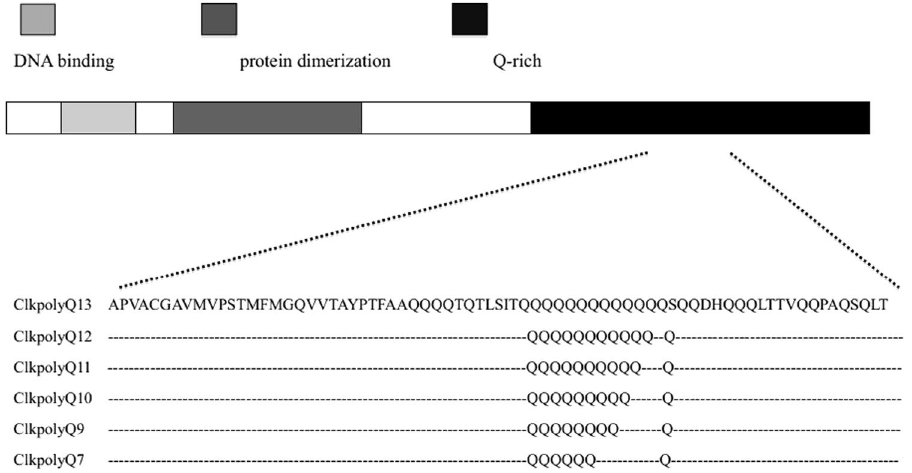
Figure 1. CLOCK poly-Q types identified in an Asian short-toed lark population in Inner Mongolia,